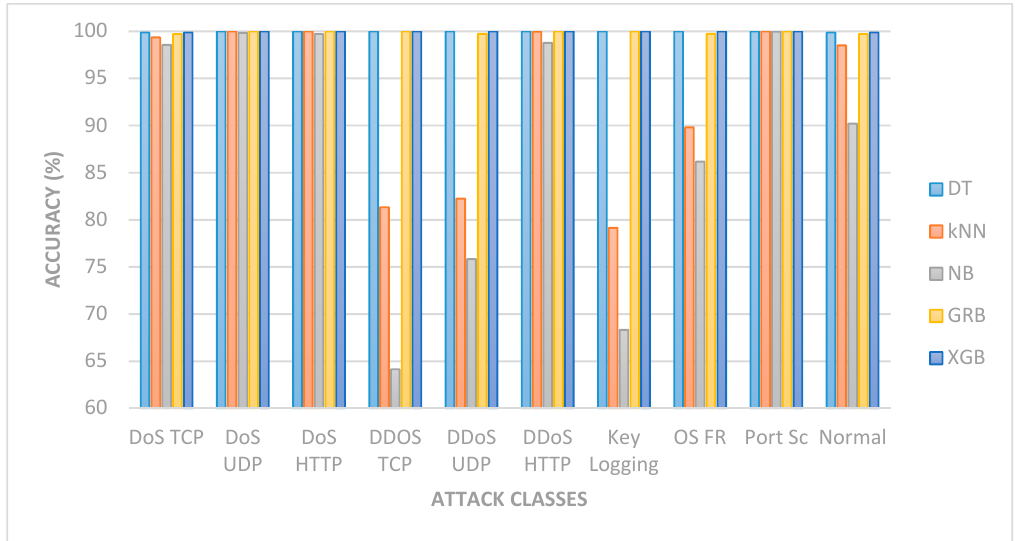
Figure 9. Performance for normal instances classification in binary classification.